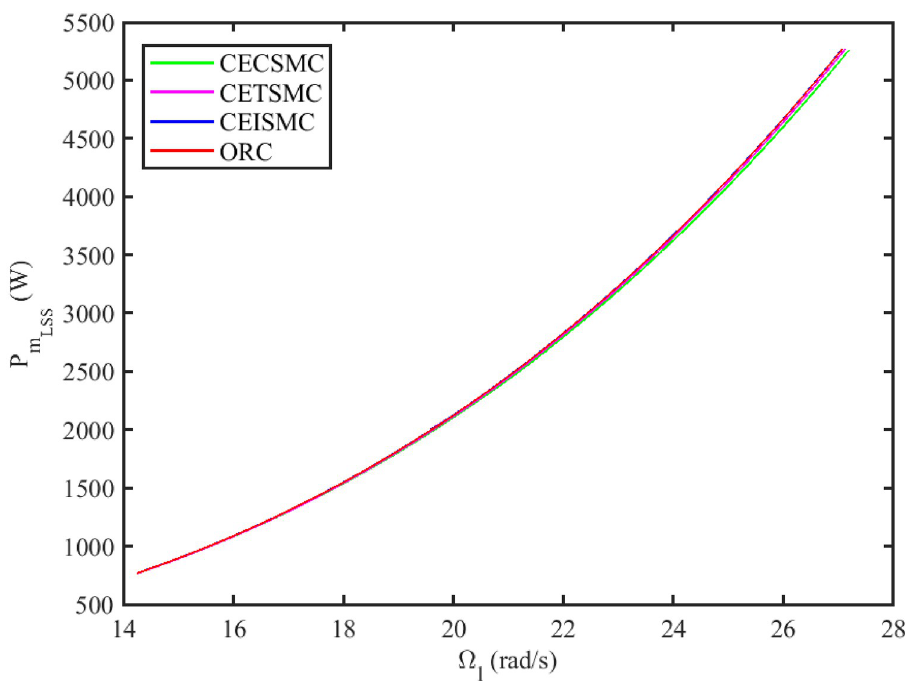
Fig 12. Low shaft rotational speed versus low-speed shaft power.